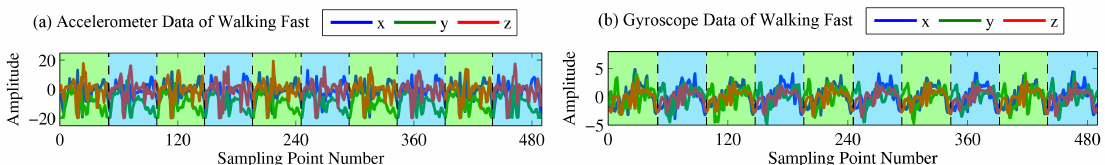
Figure 14. Accelerometer ( a ) and gyroscope ( b ) data of walking quickly.